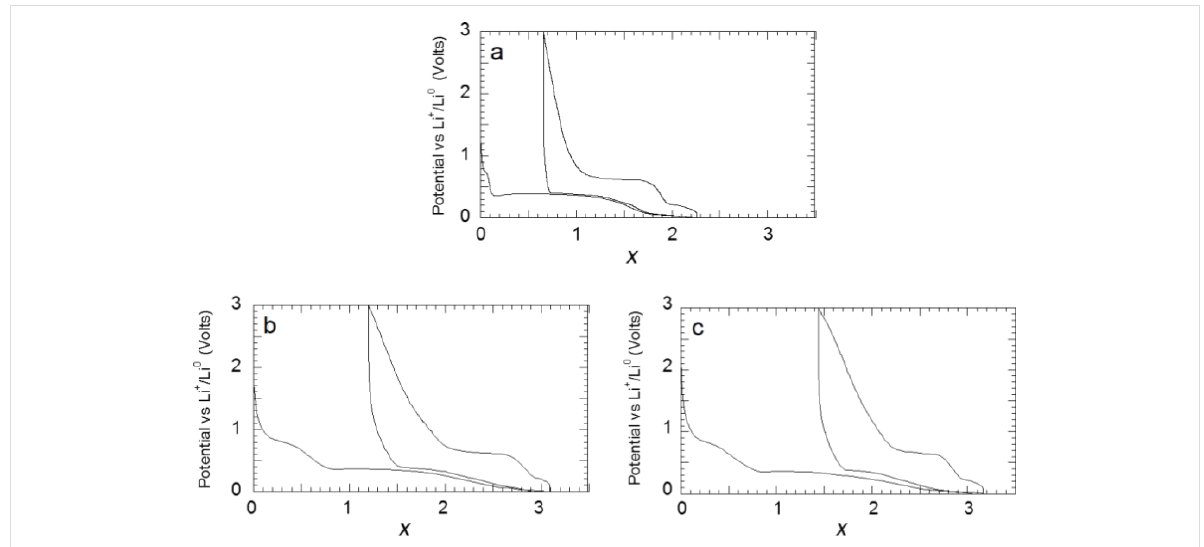
Figure 20: Evolution of the potential (V) as a function of x (mole fraction of Li) for MgH 2 electrodes cycled between 3 and 0.005 V at a rate of one equivalent of lithium in 10 h. (a) MgH 2 –18% C t , z ; (b) 33.3% MgH 2 –33.3% CMC–33.3% C t , z ; (c) 33.3% MgH 2 –33.3% CMC-f–33.3% C t , z . Adapted from [46]. Copyright 2011 Elsevier.